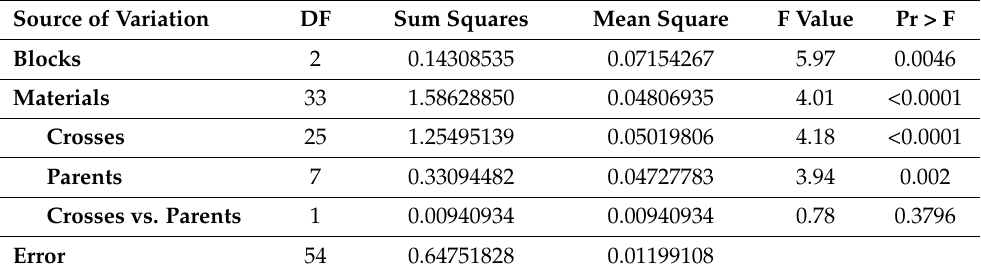
Table 2. Analysis of variance for market yield in Set 1. DF = degrees of freedom. Pr = p -value. The model adjustment (R 2 ) and error coefficient of variation are presented at the bottom of the table. Source of Variation DF Sum Squares Mean Square